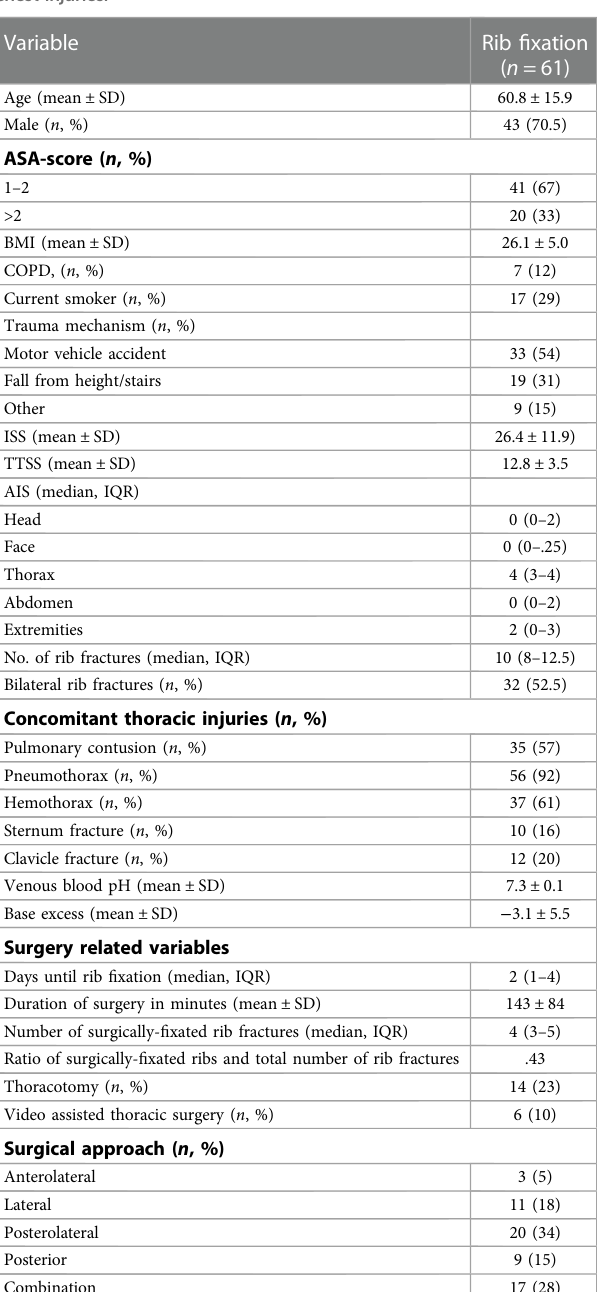
TABLE 1 Baseline characteristics of operatively treated patients with fl ail chest injuries.